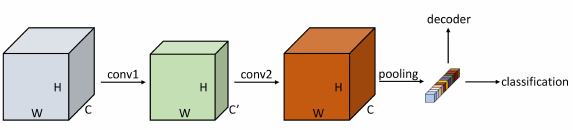
Figure 4. Details of the CP module in GCANet.